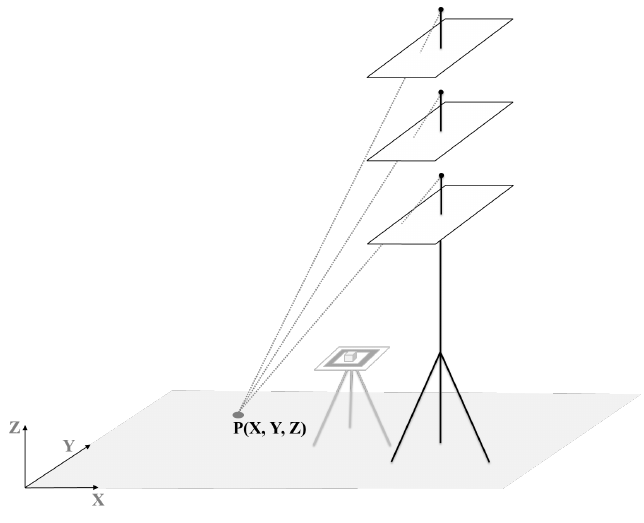
Figure 4. Multi-scale model for the 3D determination of point